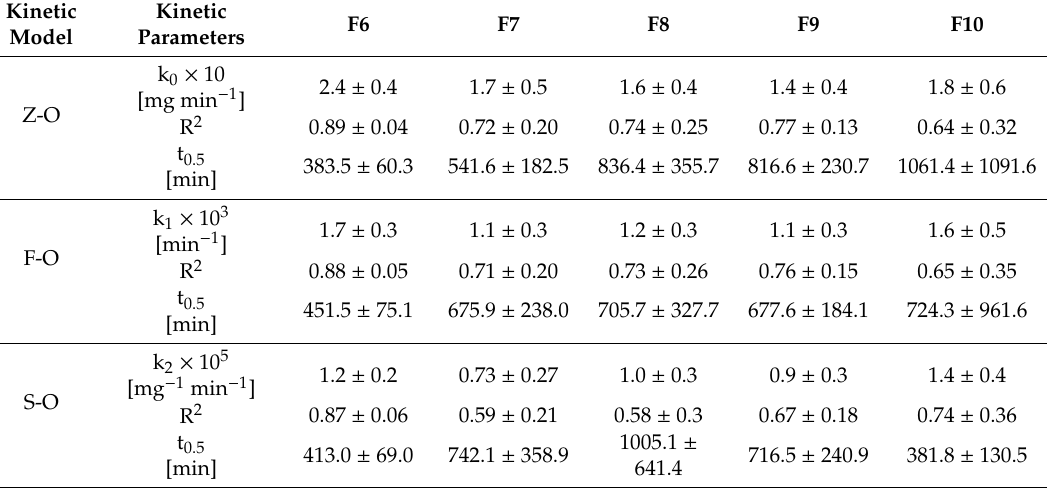
Table 2. The obtained kinetic parameters of the second stage of the